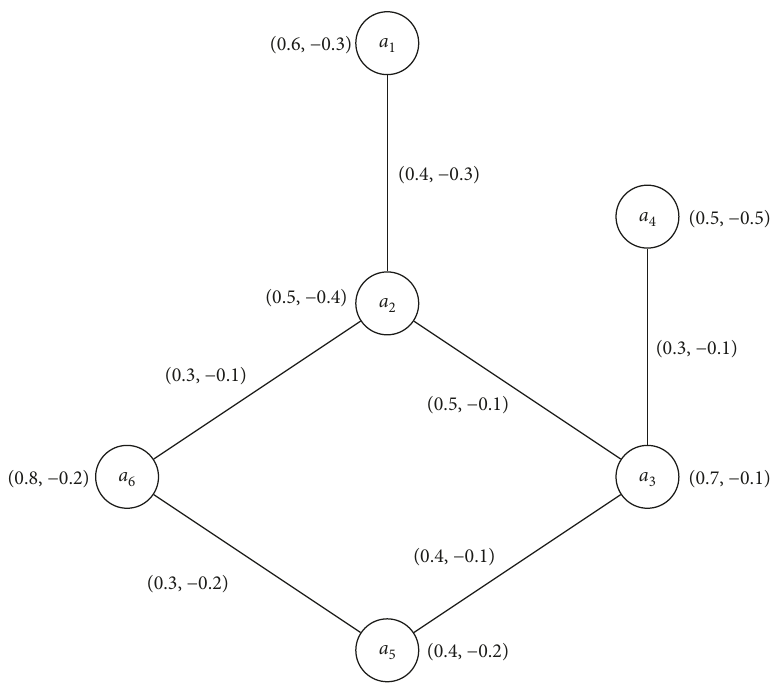
Figure 2: Bipolar-valued fuzzy social network